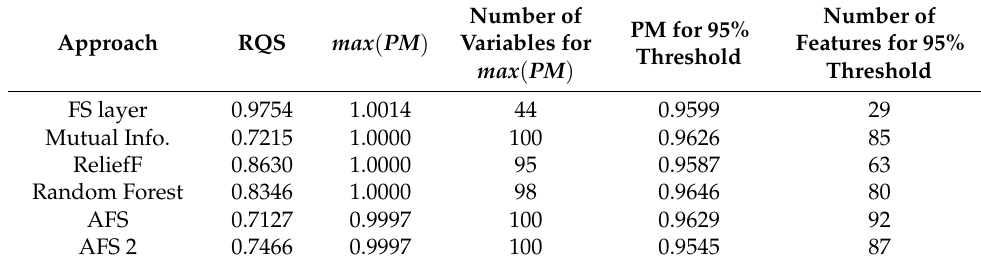
Table 9. Task performance and ranking quality for CWR